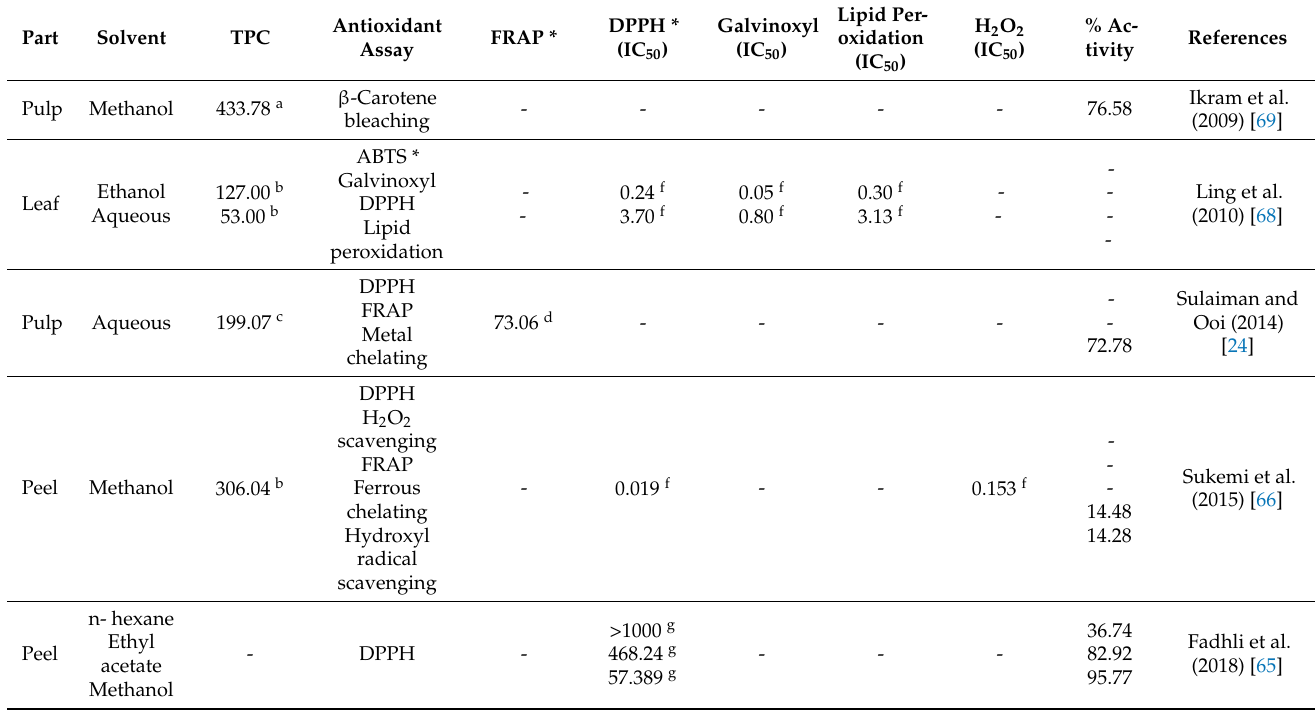
Table 6. List of antioxidant assays performed on N. ramboutan-ake